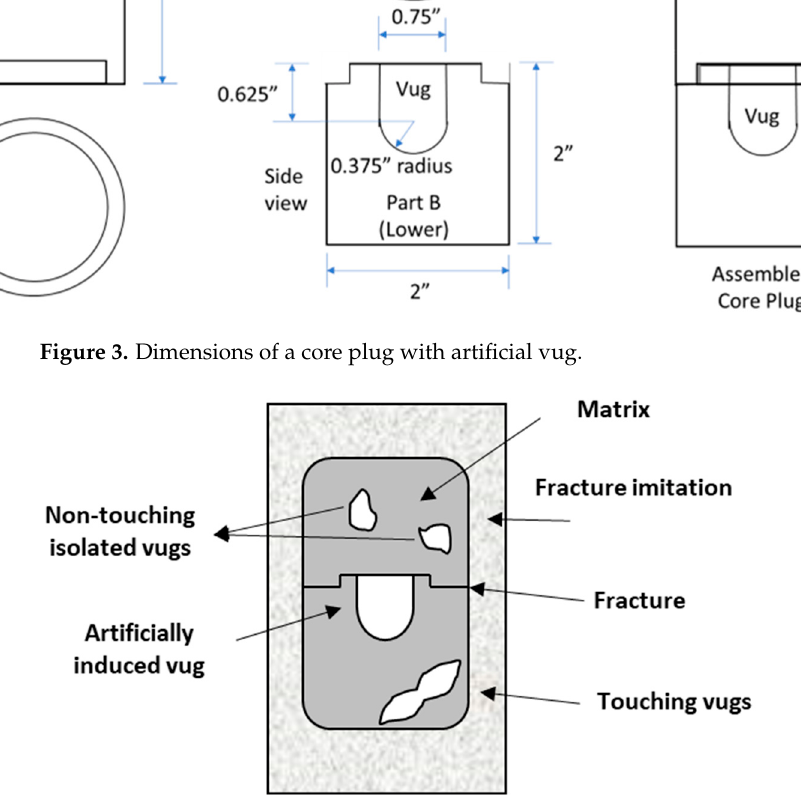
Figure 4. Triple-porosity